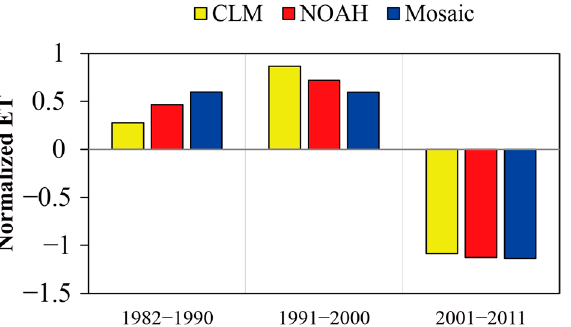
Figure 12. The normalized regional-mean ET derived from GLDAS CLM, Noah, and Mosaic.